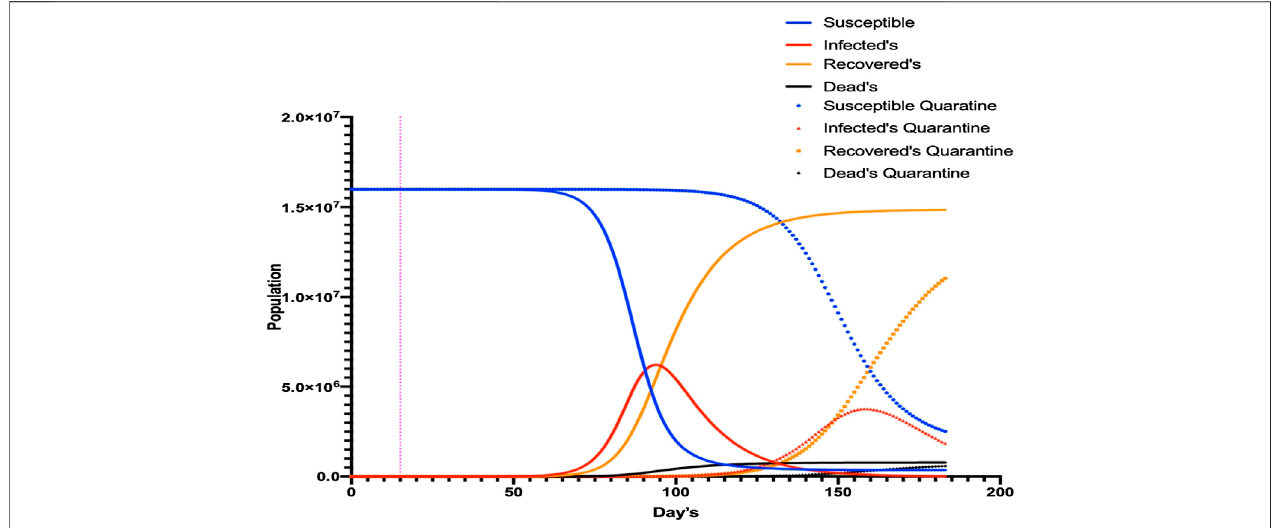
FIGURE5| SIR1modelwithmodi fi edparametersforquarantine.DifferentsimulationswereundertakenforCOVID-19,withandwithoutquarantine.Thenumberof infected individuals decreased but the duration of infectivity was prolonged by > 200 days.